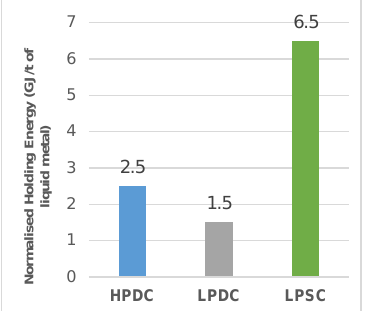
Figure 17. Holding energy per ton of liquid metal in three different Al foundries.